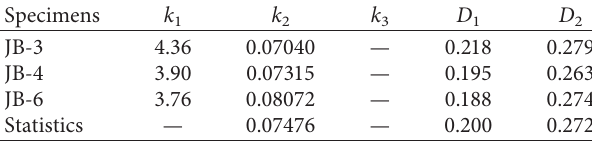
Table 4: Statistical results of relative parameters in damage